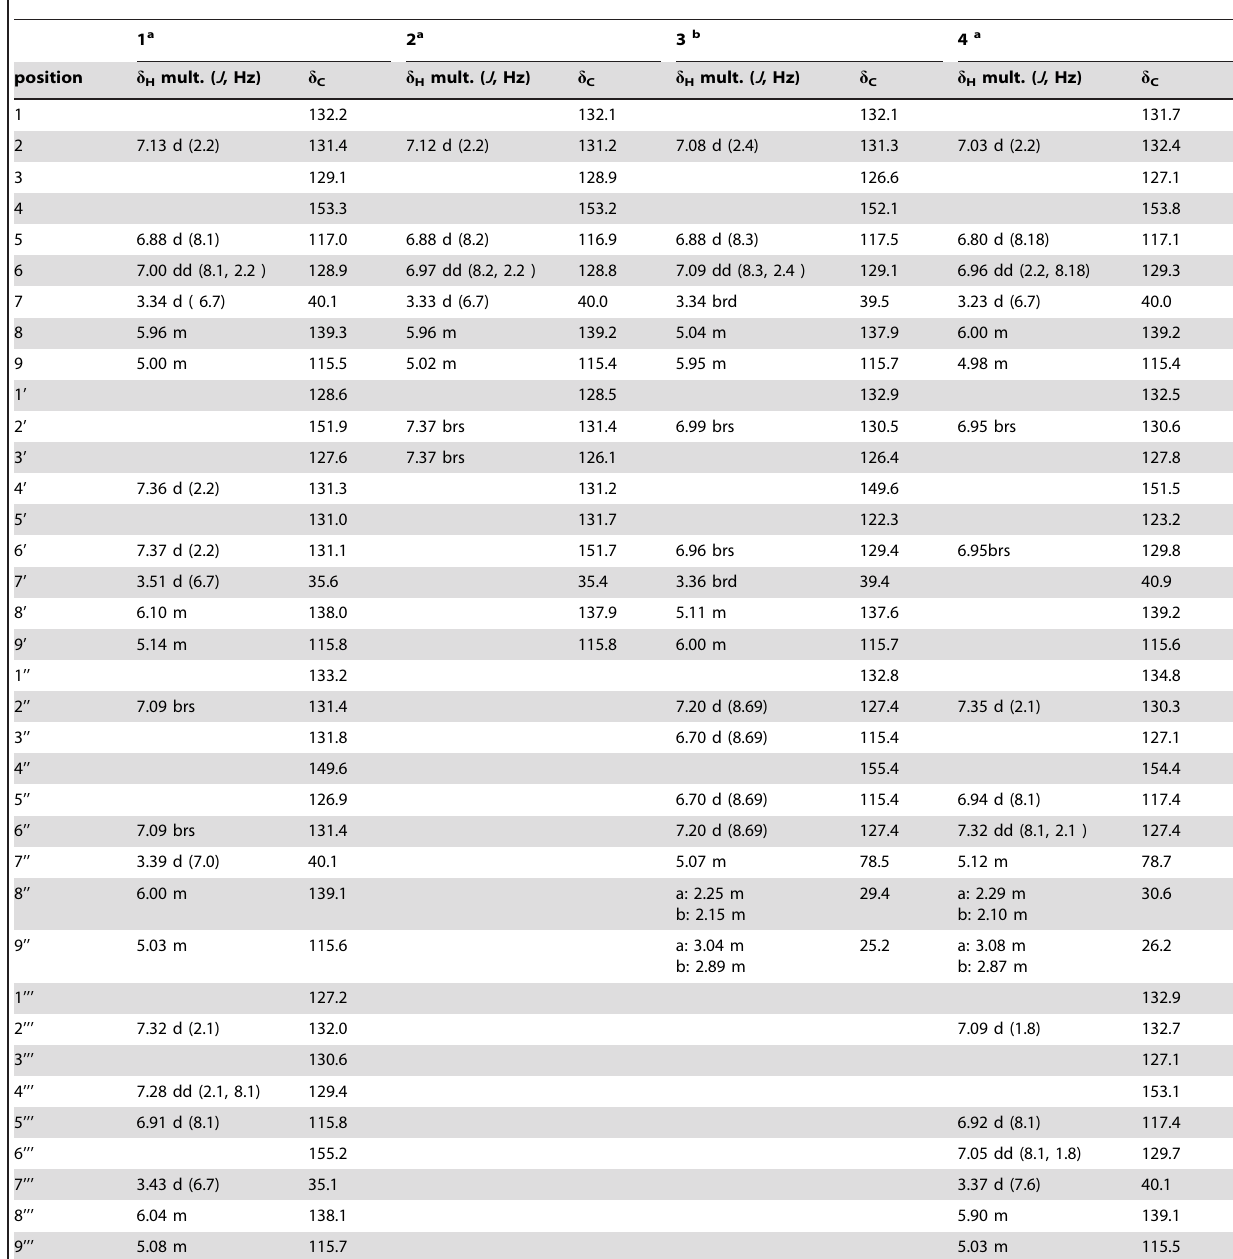
Table 1. 1 H and 13 C Spectroscopic Data of 1 – 4